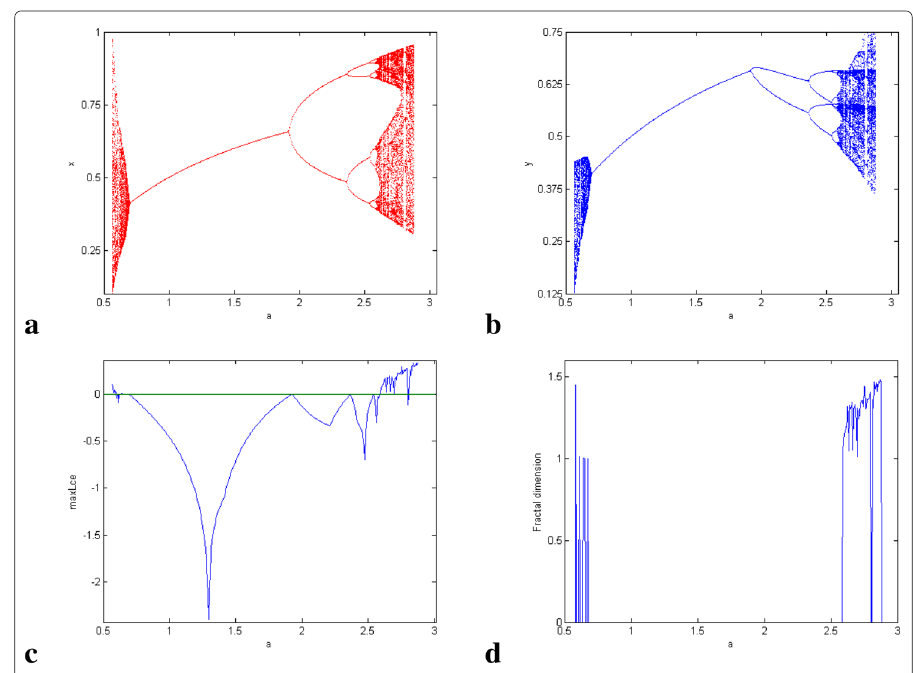
Fig. 4 NS-flip bifurcation of system (3). a Bifurcation for prey, b bifurcation for predator, c maximum Lyapunov exponents related to a , b . d FD associated with a . ( x 0 , y 0 ) = ( 0.37,0.37